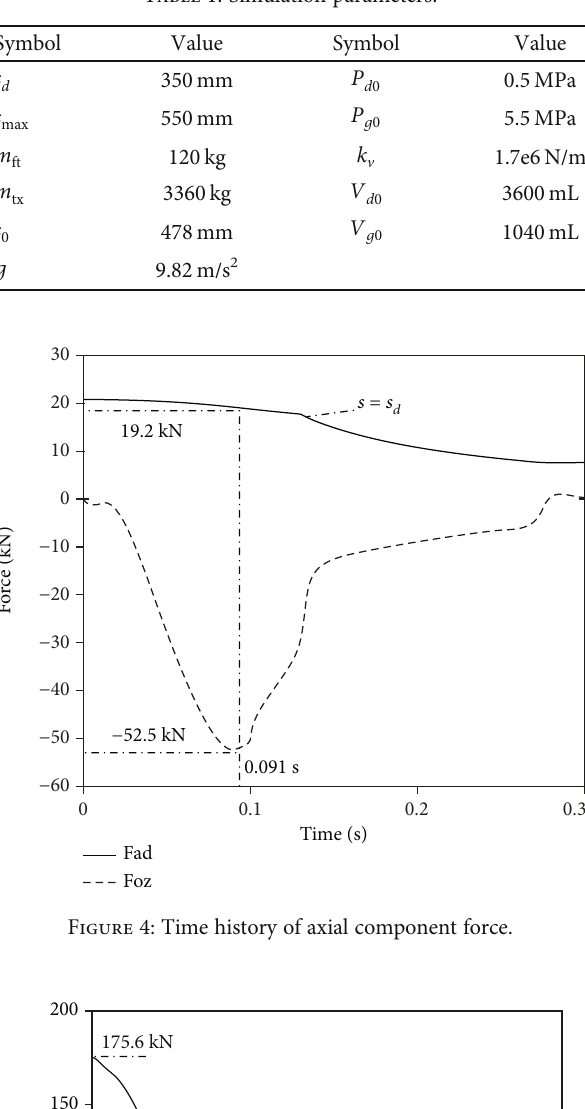
Figure 7: Comparison of shock strut stroke.